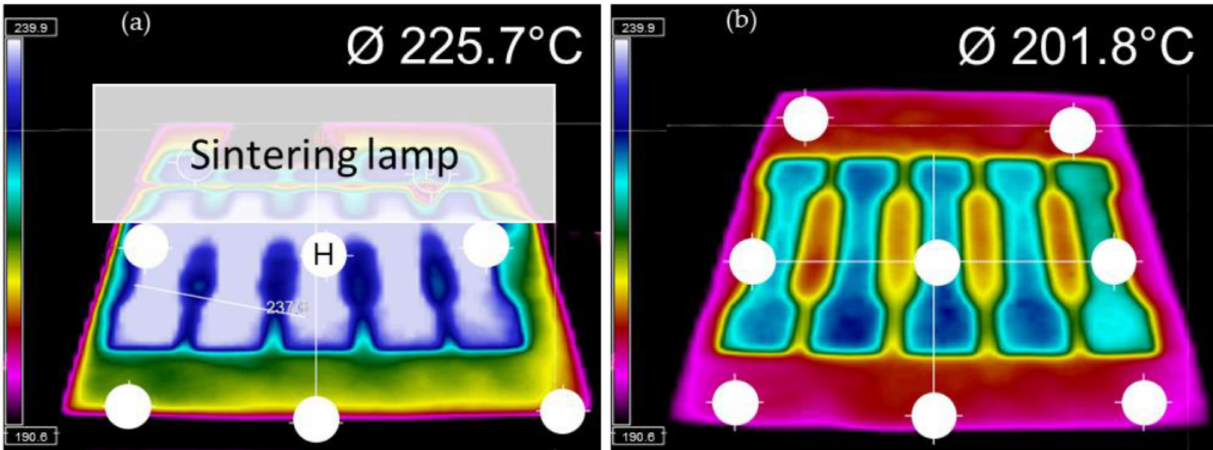
Figure 7. ( a ) Infrared thermal camera images showing the temperature across the bed during the passage of the sintering lamp. Point H was the hottest with a temperature of 244 ◦ C. Note that the sintering lamp cannot be seen as it is made of reflective metal but its position is indicated by the white rectangle and the reflection of the bars is seen. ( b ) Immediately after recoating a new layer of the colder PET powder, the average temperature drops to 201.8 ◦